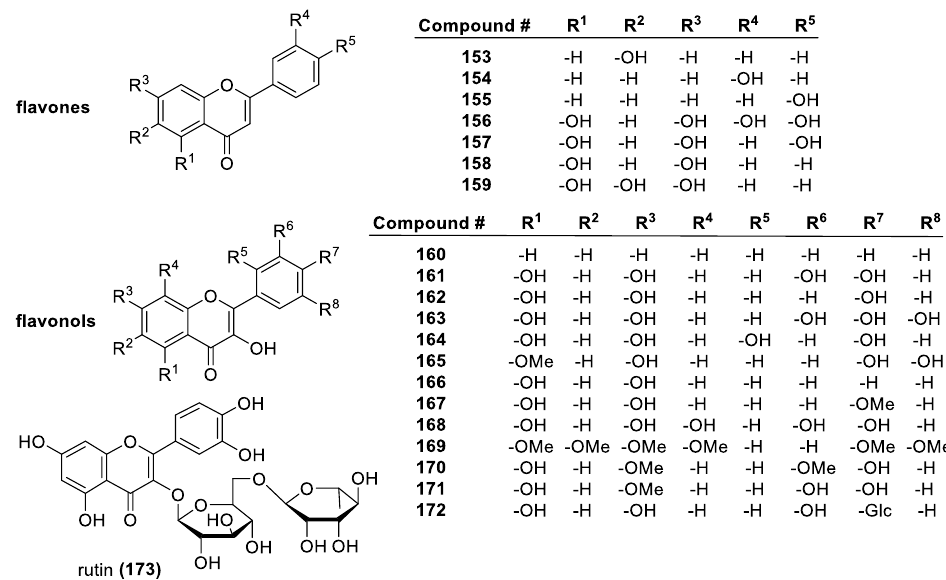
Figure 11. Representative examples of flavones and flavonols with antioxidant effect.